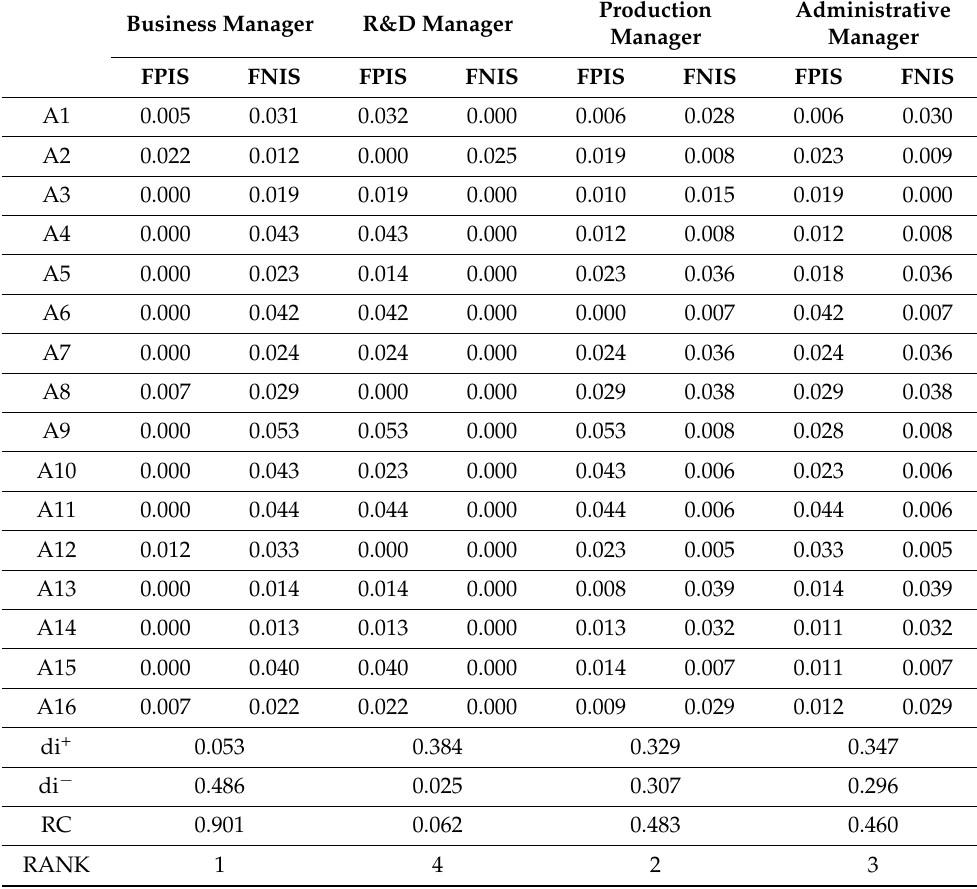
Table 11. Distance from positive and negative ideal solutions and solution